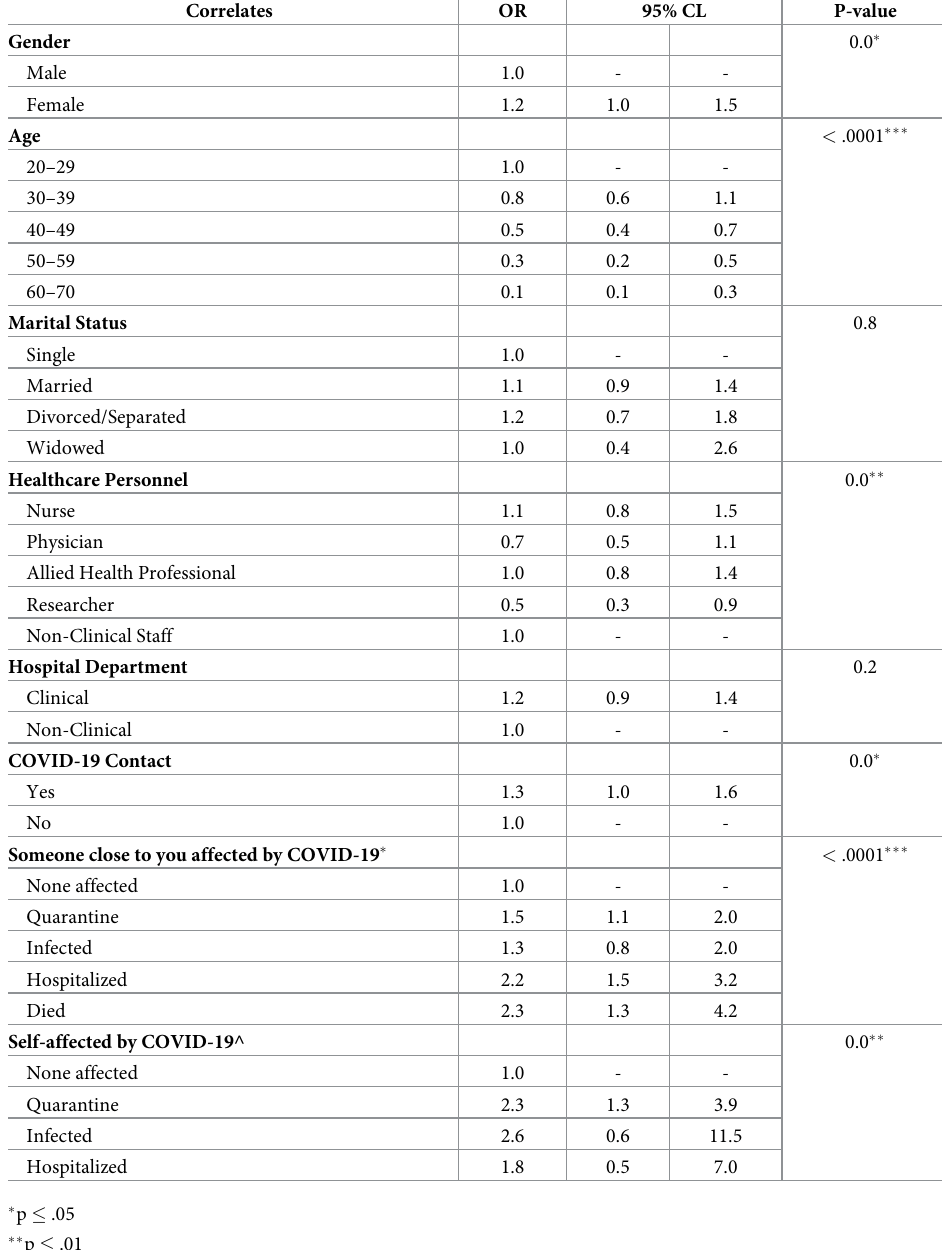
Table 3. Proportional odds model with non-modifiable correlates predicting psychological distress (N = 1810).